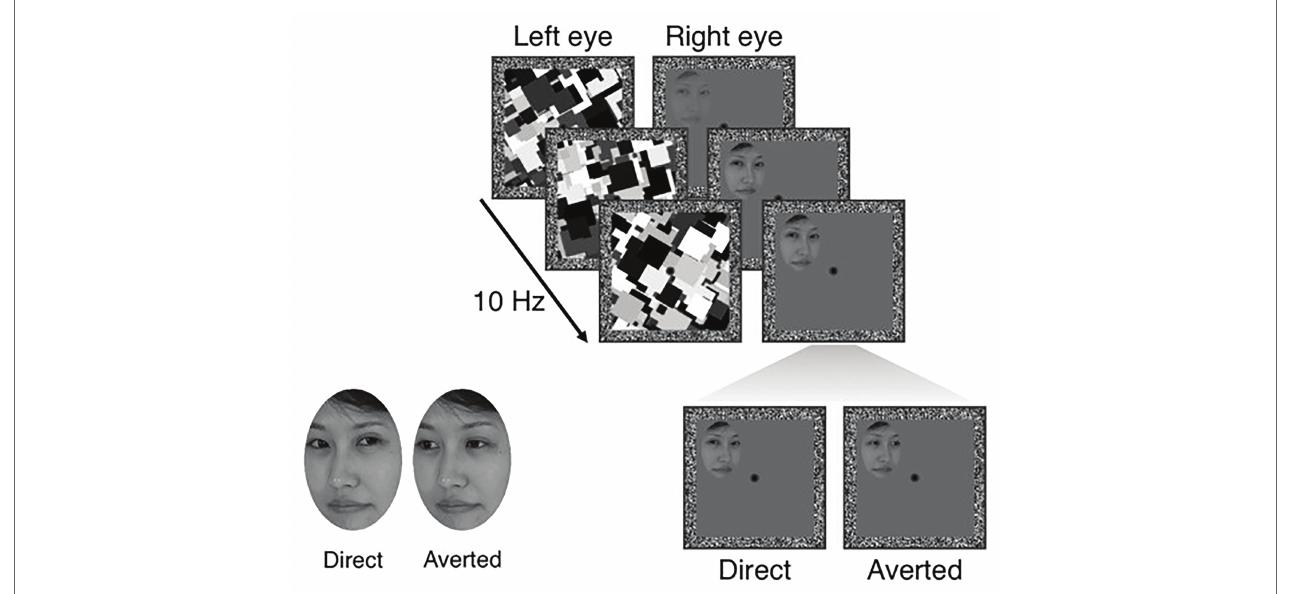
FIGURE 2 | Experimental sequence of the unconscious gaze task. Both eyes of the participants received separate stimulation through a mirror stereoscope. One eye was shown the target stimulus (faces with either direct or averted gaze), whose conscious perception was suppressed by a dynamical mask shown to the other eye. Participants were instructed to indicate the localization of a face as soon as it broke through the mask, while not being told that faces differed with respect to gaze. By subtracting mean response times for averted gaze from mean response times for direct gaze, we obtained a measure of the preferential unconscious processing or prior for direct gaze. Figure adapted from Stein et al. (2011b).